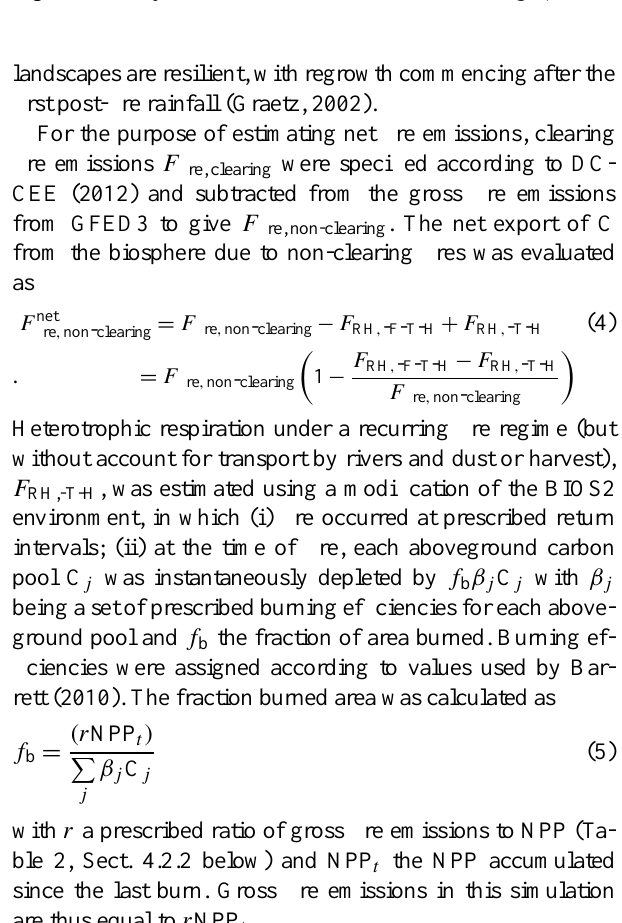
Fig. 1. Summary of the Australian territorial carbon budget, 1990–2011.